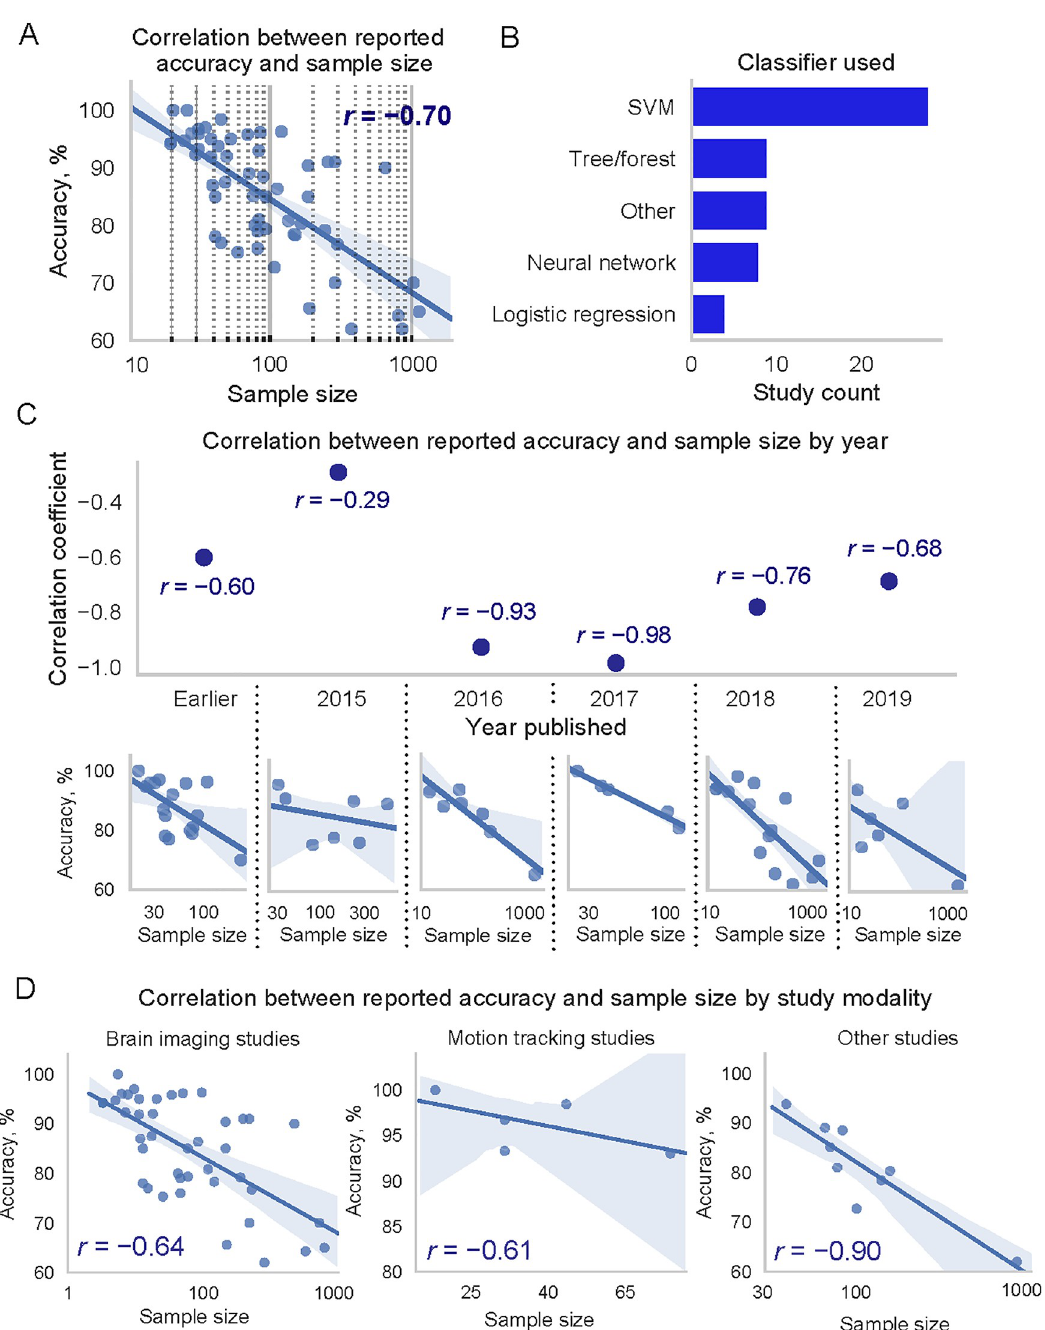
Fig 1. Relationship between log 10 transformed sample size and reported accuracy. For 55 studies in the survey which applied ML methods in autism research. A : Relationship between log 10 transformed sample size and accuracy, with a dark blue regression line and light blue area showing 95% confidence intervals. B : Classifiers used in the studies. C : Relationship between reported accuracy and log 10 transformed sample size by year, bottom scatter-plots are for the studies published in that year. Year 2019 includes studies up to 18/04/2019 when the literature search was performed. N—sample size. D : Relationship between reported accuracy and log 10 transformed sample size by modality of data used in the